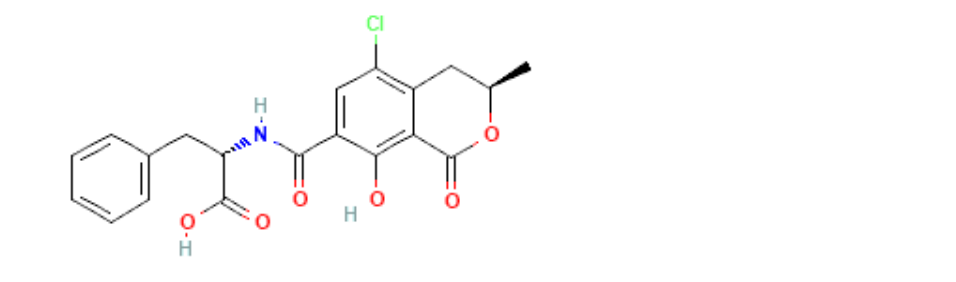
Figure 7. The molecular structure of OTA, the amide bond, ester, Cl and epoxide moiety at the site of detoxification.